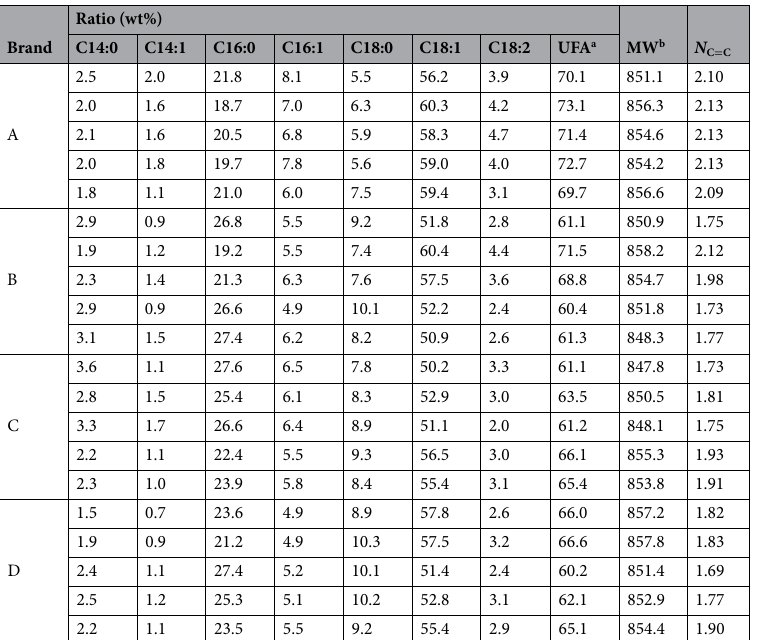
Table 2. Fatty Acid Composition of the Sirloin Derived from Japanese Black Cattle. a Total ratio of unsaturated fatty acids. b Averaged molecular weight of triacylglycerol